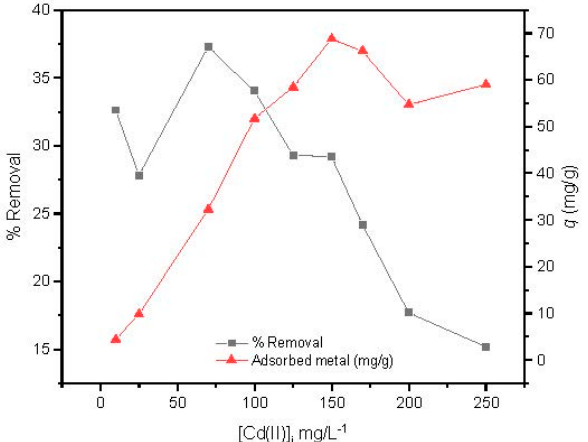
Figure 7. Effect of Cd(II) initial concentration.